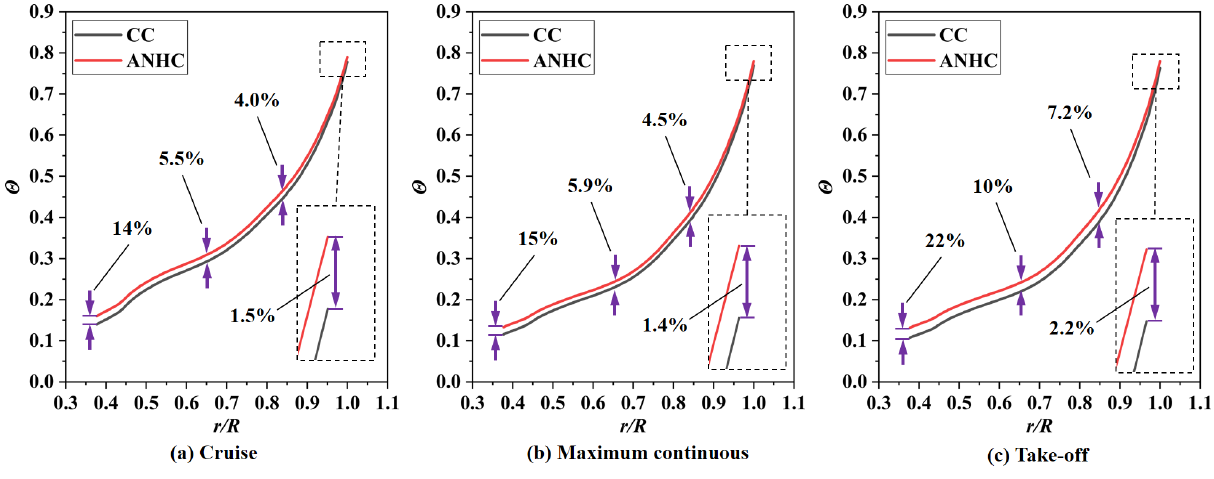
Figure 20. Dimensionless metal temperatures under CC and ANHC.